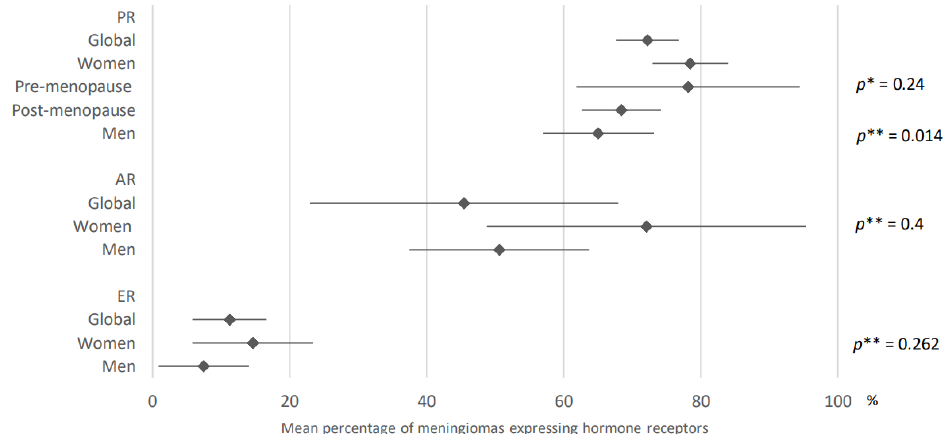
Figure 4. Comparison of hormone receptors expression in meningiomas according to gender. PR: progesterone receptors; AR: androgen receptors; ER: estrogen receptors. The results are expressed as a mean associated with their 95% confidence interval. p *: pre-menopause versus post-menopause, p **: men versus women. Number of articles analyzed related to the topic: Progesterone receptors: